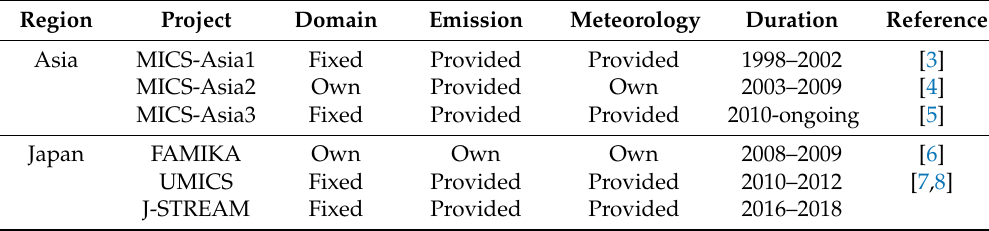
Table 1. Outlines of model inter-comparisons conducted for Asia and